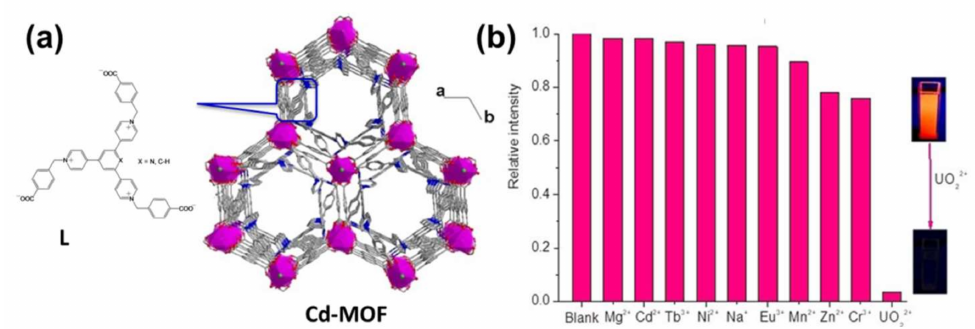
Figure 12. ( a ) Structure of L and Cd-MOF. ( b ) Fluorescence response of Cd-MOF to different metal ions. Adapted from [94]. Table 2. The hazardous metal ion detection ability and detection mechanisms of various LMOF- based